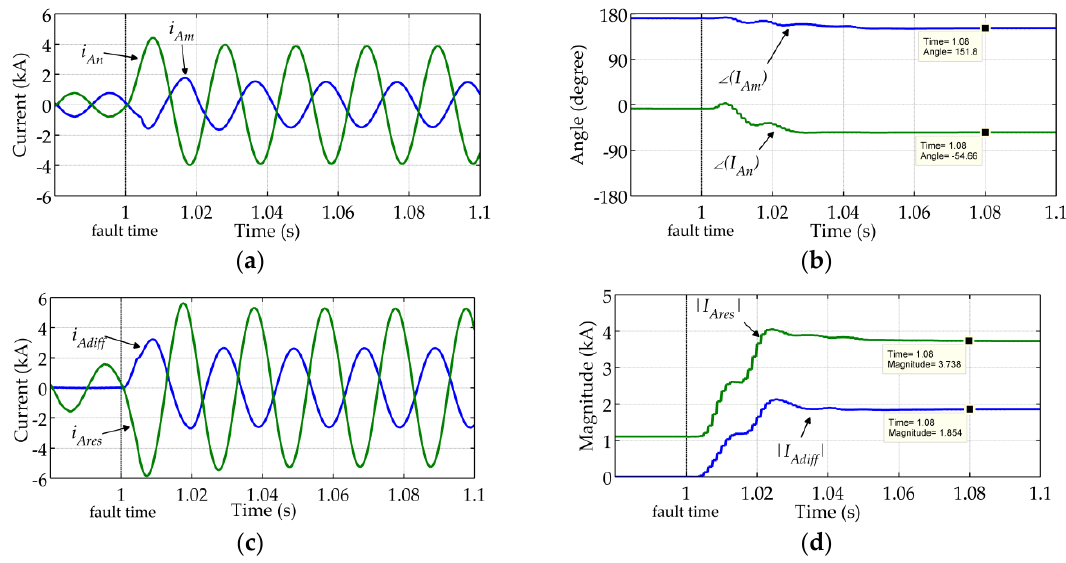
Figure 18. İ Am , İ An , İ diff , and İ Ares : ( a ) İ Am and İ An ; ( b ) Phase angles of İ Am and İ An ; ( c ) İ diff and İ Ares ( d ) Figure 18. ˙I Am , ˙I An , ˙I diff , and ˙I Ares : ( a ) ˙I Am and ˙I An ; ( b ) Phase angles of ˙I Am and ˙I An ; ( c ) ˙I diff and ˙I Ares Magnitudes of İ diff and İ Ares . ( d ) Magnitudes of ˙I diff and ˙I Ares